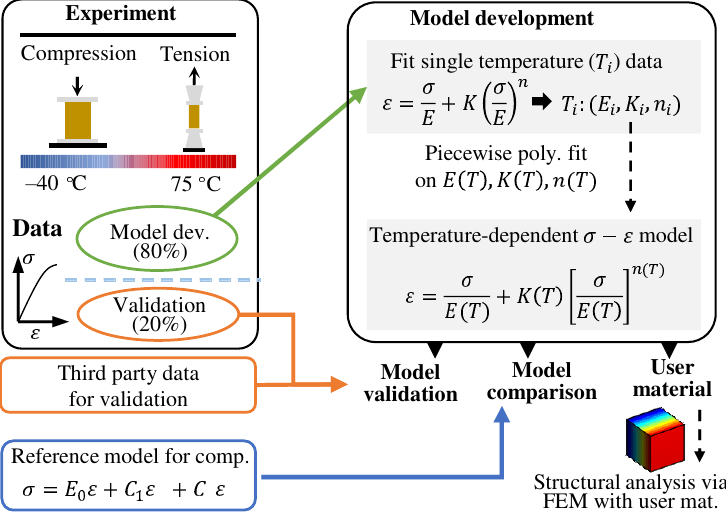
Figure 1. Flow diagram of the study process. There are 5 main parts: experiment, model development, validation, comparison, and FEM usermat.